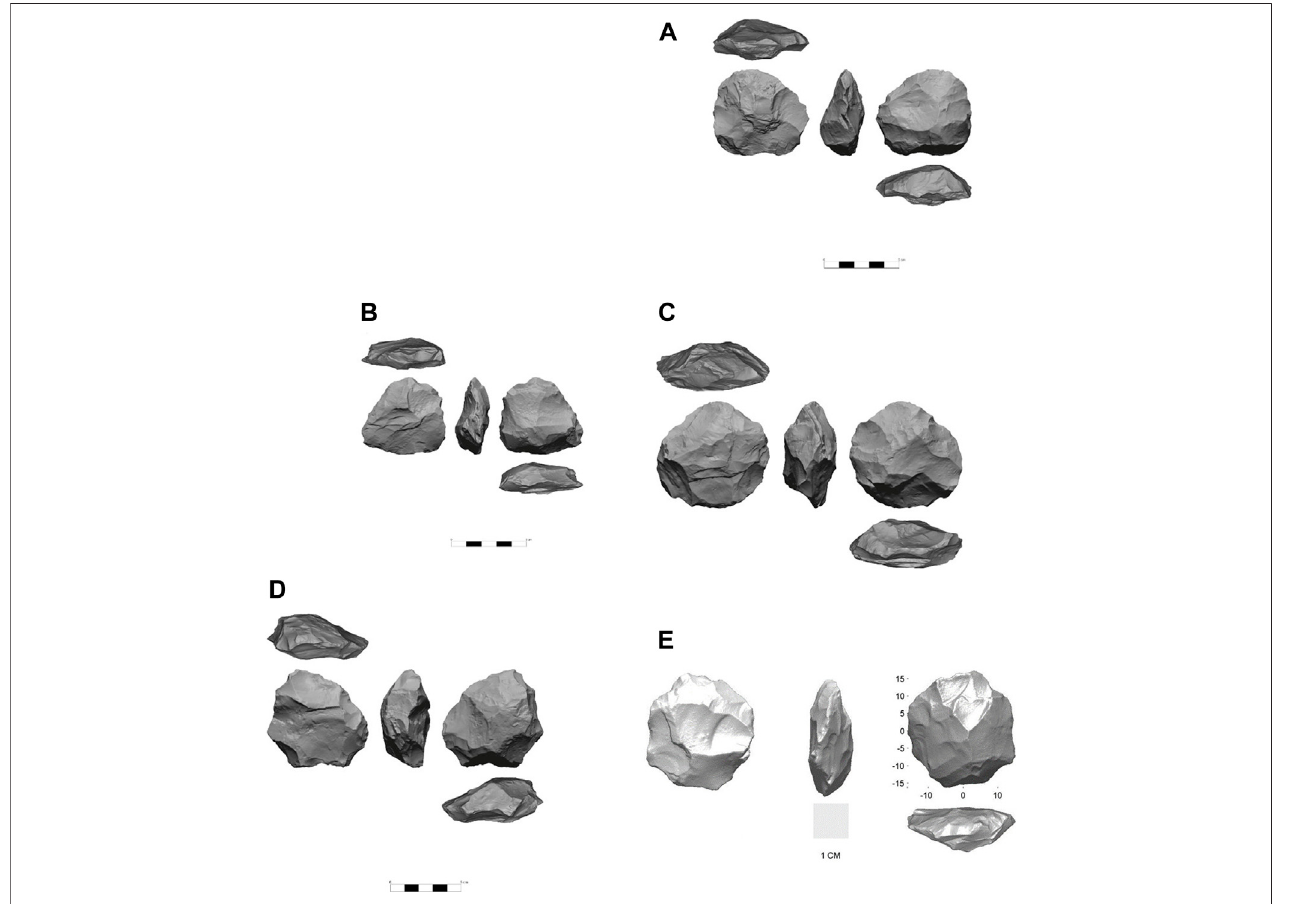
FIGURE2| Proto-Levalloiscentripetal (A – C) andpreferential (D,E) coresfromRevadim.Note thescarsontheproduction surfaces indicating débordant removals (A,D,E) . (E) Note the extremely small size of the core. The striking platform is shown in the left part of each fi gure.